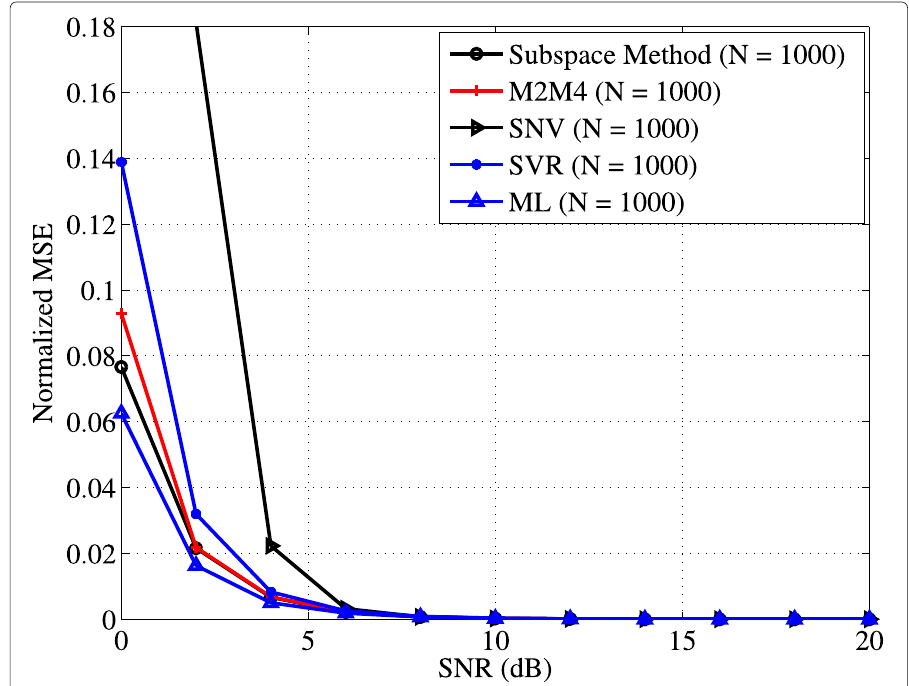
Fig. 2 The NMSE comparison of several SNR estimators. The NMSE of SVR, SNV, M 2 M 4 , subspace method, and ML under N =